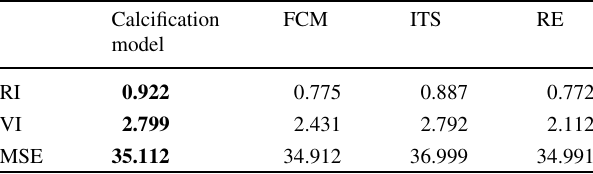
Table 4 Calcificationmodelevaluationprocedureofthesecondclinical expert